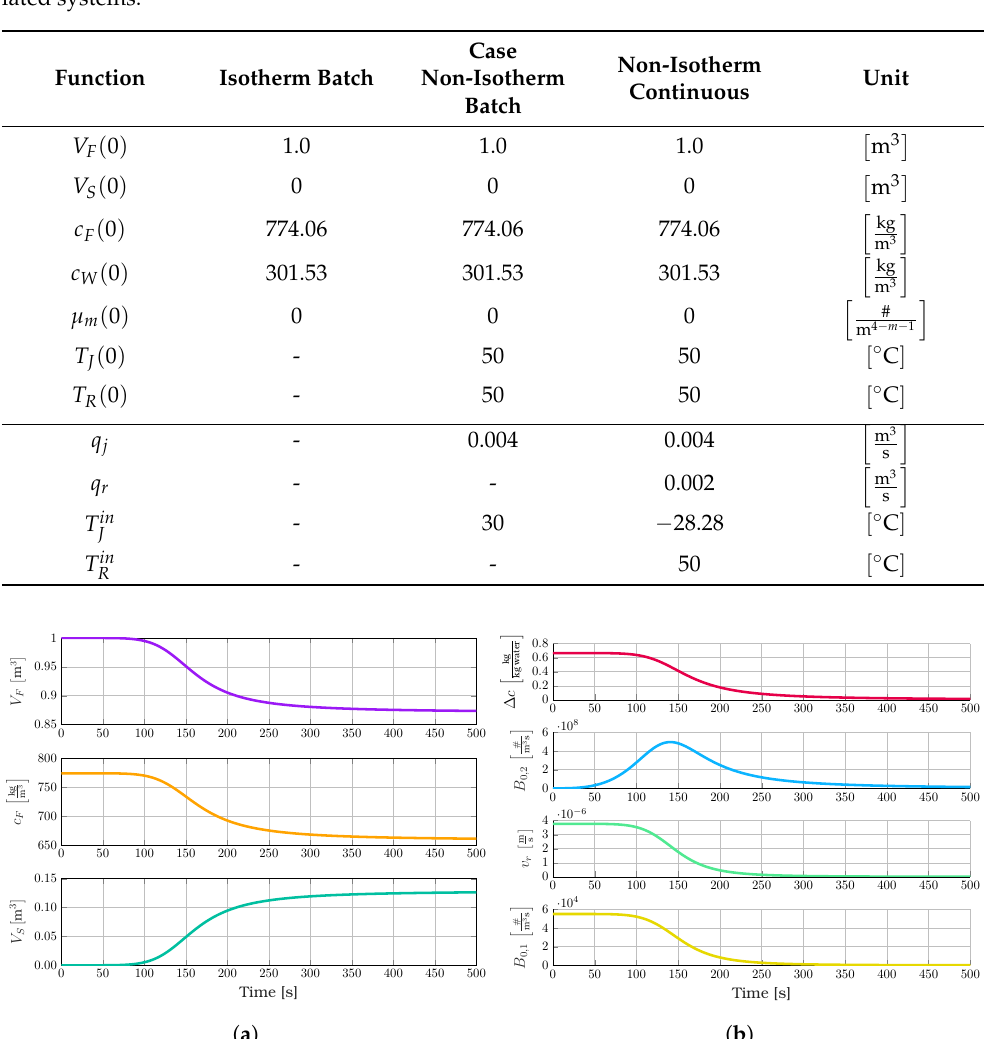
Table 3. Initial values of the differential equation systems and operation conditions of the calcu- lated systems.